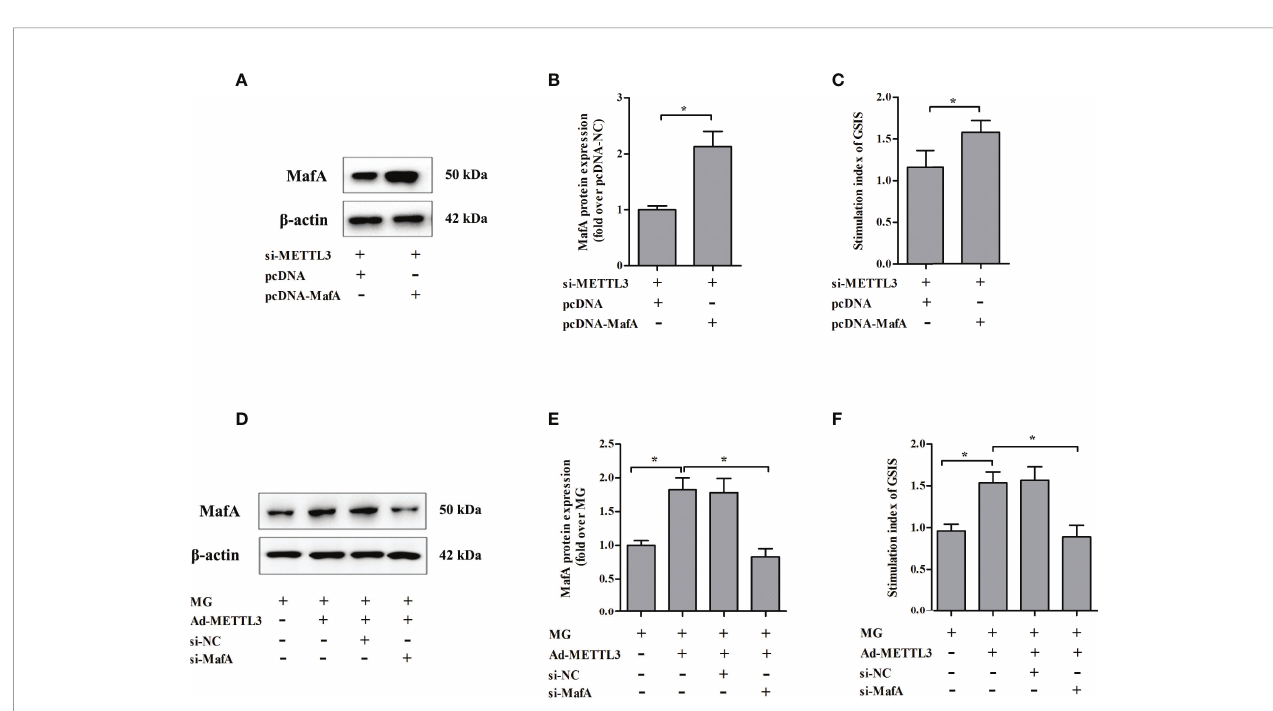
FIGURE 6 | Changes in MafA expression were associated with METTL3-regulated GSIS from NIT-1 cells. (A) Immunoblot of MafA expression in NIT-1 cells transfected with si-METTL3 + pcDNA or si-METTL3 + pcDNA MafA. (B) Quanti fi cation of the immunoblot in (A) . (C) The GSIS index of the cells described in (A) . (D) Immunoblot of MafA expression in NIT-1 cells transfected with Ad-METTL3 + si-NC or Ad-METTL3 + si-MafA and treated with 1 mM MG for 24 h. (E) Quanti fi cation of the immunoblot in (D) . (F) The GSIS index of the cells described in (D) . Results are presented as means ± SD of n = 3 ‐ 4 independent experiments. * p <